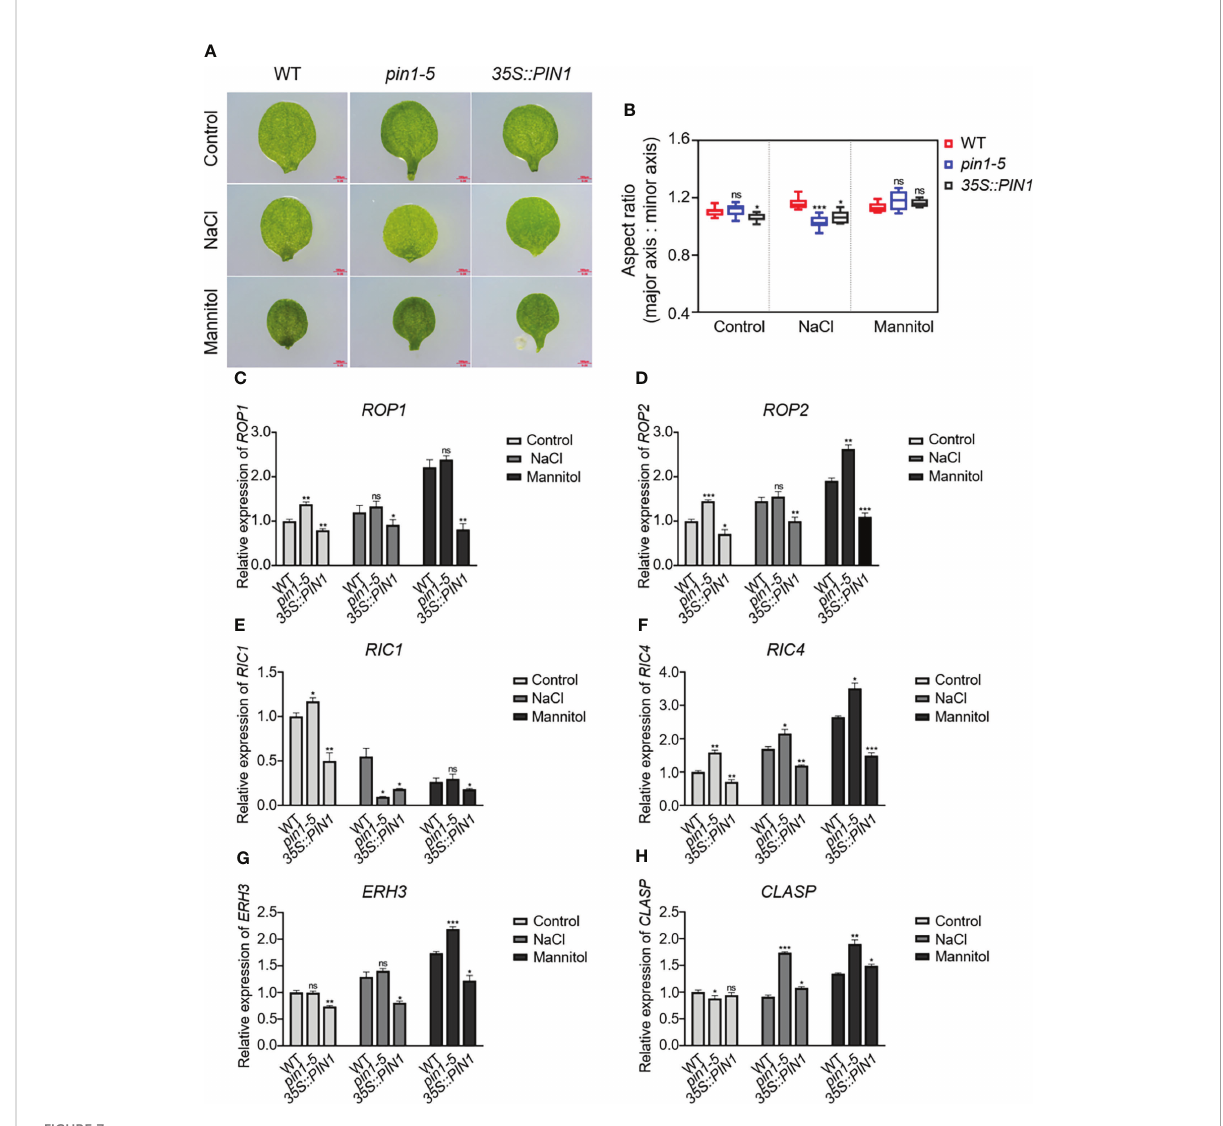
FIGURE 7 Effects of PIN1 on cotyledon morphological development. (A) The wild-type (WT) seedlings, pin1-5 and 35S::PIN1 , were grown in 1/2 MS plates, 1/2 MS plates plus 100 mM NaCl, and 1/2 MS plates plus 150 mM mannitol for 7 days, and the development of cotyledons was observed on micrographs. Scale bars, 0.5 mm. n ≥ 8 cotyledons per genotype. (B) Boxplots represent the aspect ratio of WT and mutant cotyledons. (C-H) qPCR analysis of the relative expression of ROP1 , ROP2 , RIC1 , RIC4 , ERH3 , and CLASP under control, NaCl, and mannitol conditions, respectively. Relative expression indicates the mean value ( ± SD) of three independent experiments. The data were analyzed by